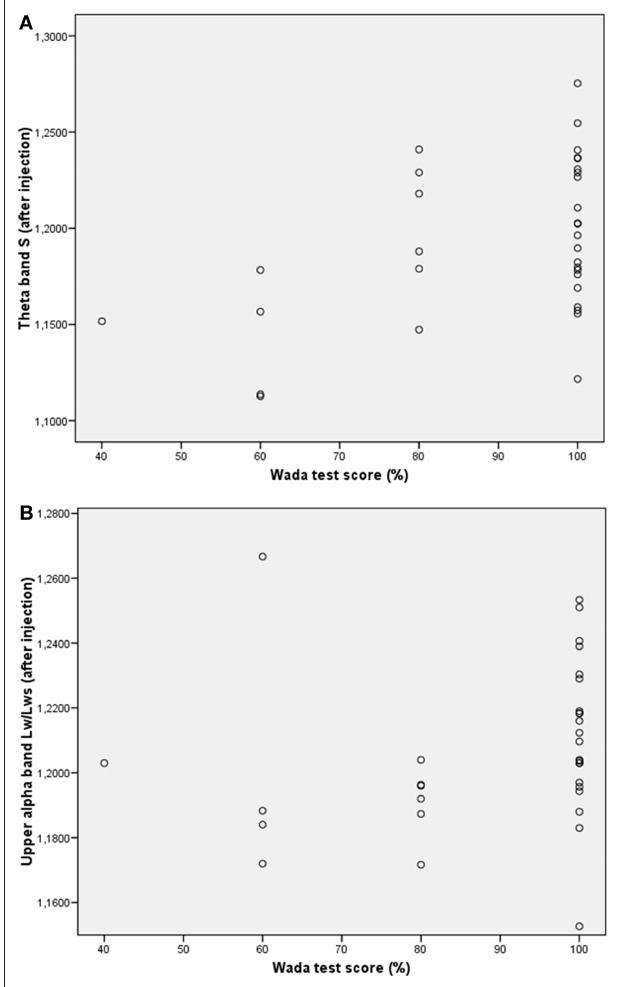
FigUre 3 | Scatterplots of correlations between network variables and memory performance during the iap. (a) Correlation between theta band small-worldness ( S ) and memory score. (b) Correlation between upper alpha band path length and memory